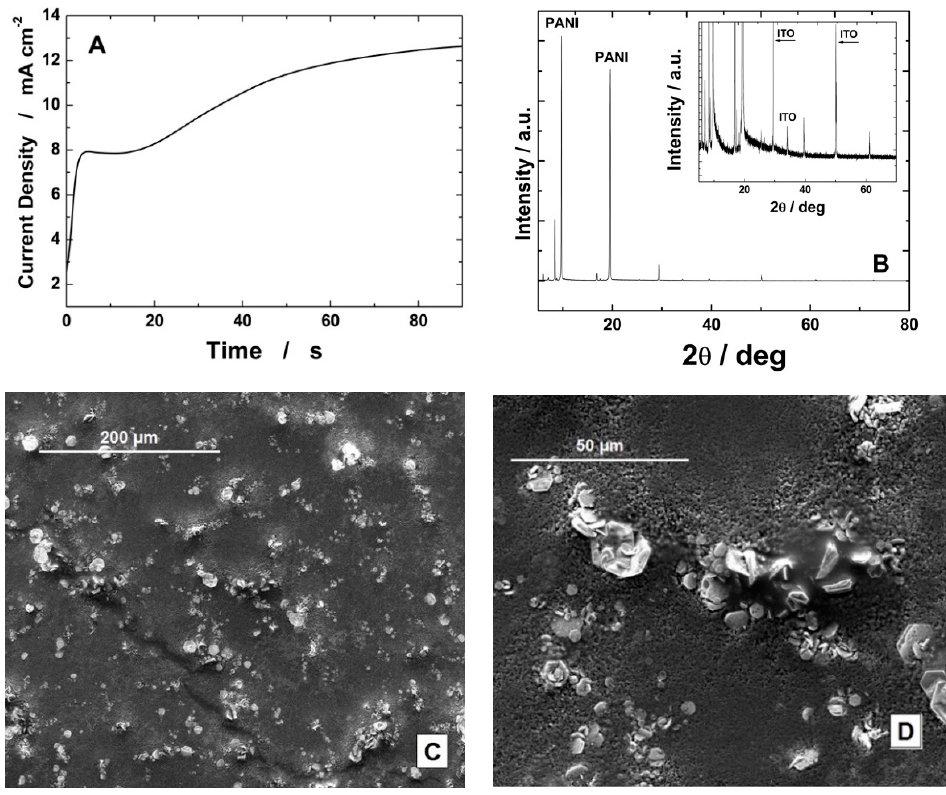
Figure 1. ( A ) Growth curve for the electrochemical deposition of PANI on ITO-PET substrate; ( B ) XRD pattern of PANI-ITO glass; ( C , D ) SEM images of PANI/ITO-PET electrode.